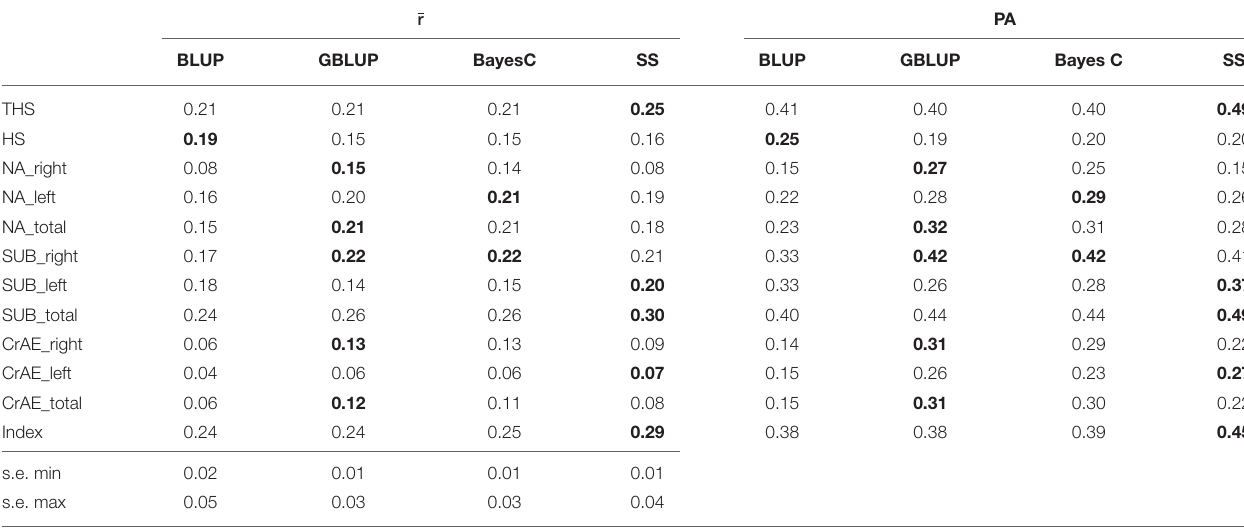
TABLE 2 | Estimates of the correlation of the predicted EBV with phenotypes, averaged over the five validation sets ( r ) and the predictive abilities (PA) for the estimated breeding values. r PA BLUP GBLUP